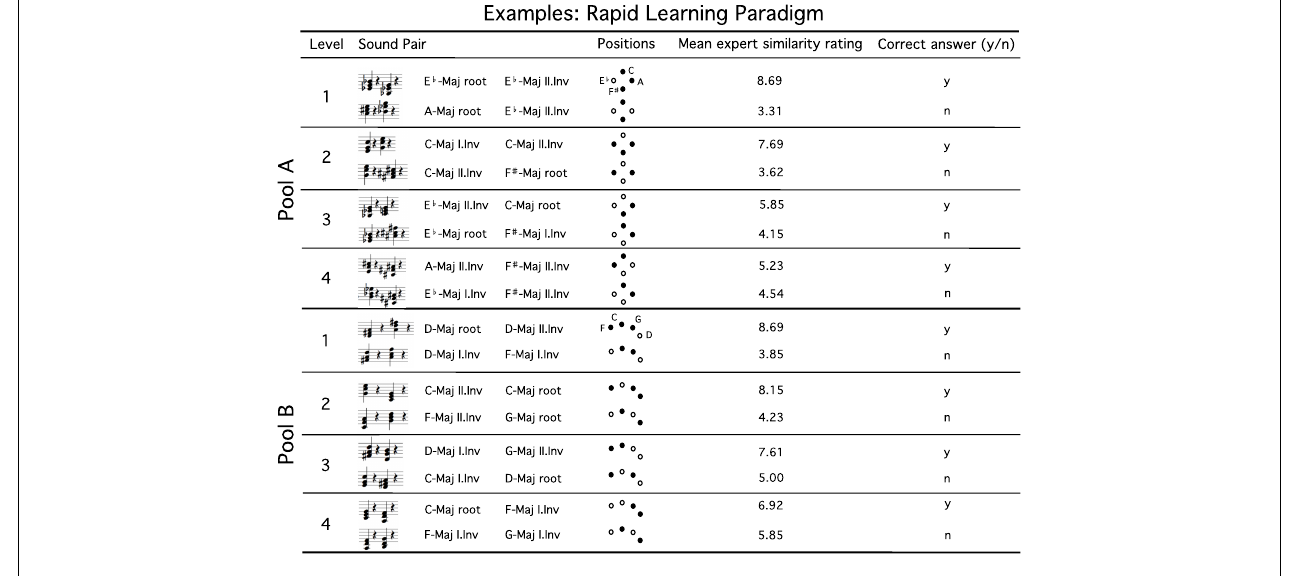
show one example of relatively high [correct answer: yes (y)] and one of relatively low similarity [correct answer: no (n)], which represent expert’s ratings given as mean similarity values. Mean expert ratings provide the base for the allocation of each sound pair to one of the four levels to be accomplished by performing the rapid learning paradigm (abbreviations: root = root position of a major chord; I./II. Inv = first/second inversion of a major